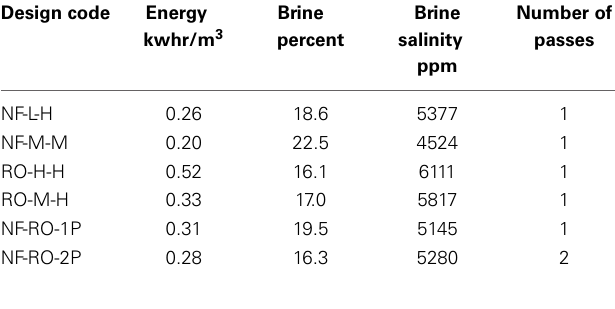
Table 3 | Output technologies for irrigation (IMSDesign software).